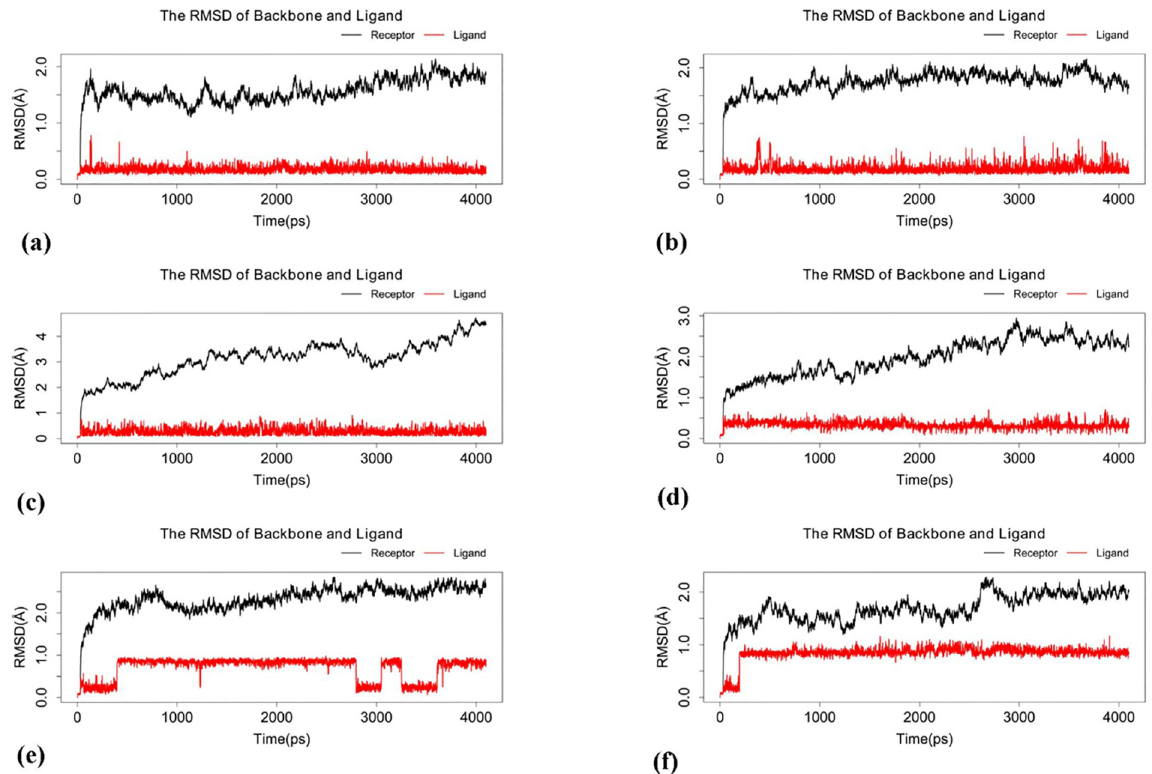
Fig 3. Plot of RMSD versus time (ps) for (a ) CDK-2_cmpd44 ( b ) CDK-6_cmpd59 ( c ) Topoisomerase-I_cmpd37 ( d ) Topoisomerase- II_cmpd37 ( e ) Bcl-2_cmpd46 ( f ) VEGFR-2_cmpd37. The black line corresponds to the RMSD curve of backbone atoms of protein whereas the red line indicates RMSD curve of heavy atoms of